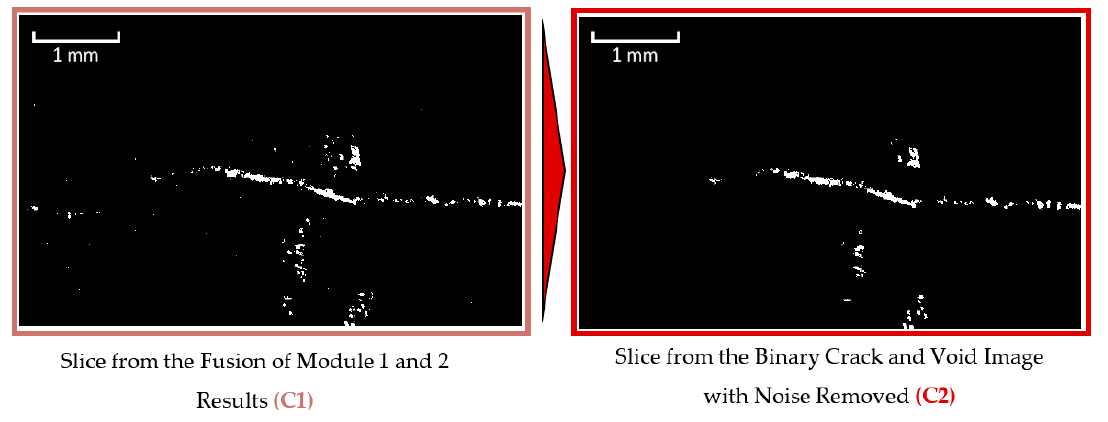
Figure 11. Removal of noise from binary crack and void image (based on figure in [10]).